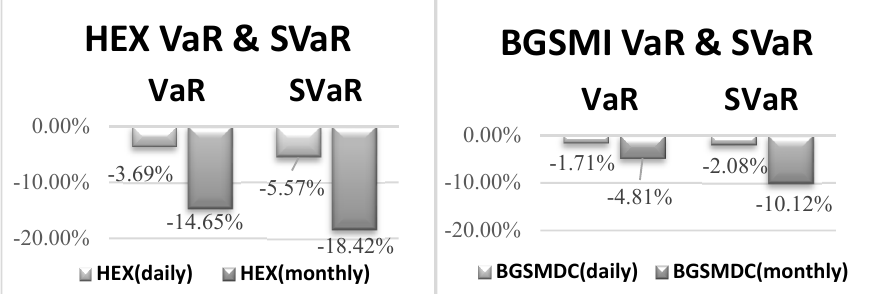
Figure 4. VaR versus SVaR equities. Source: authors.